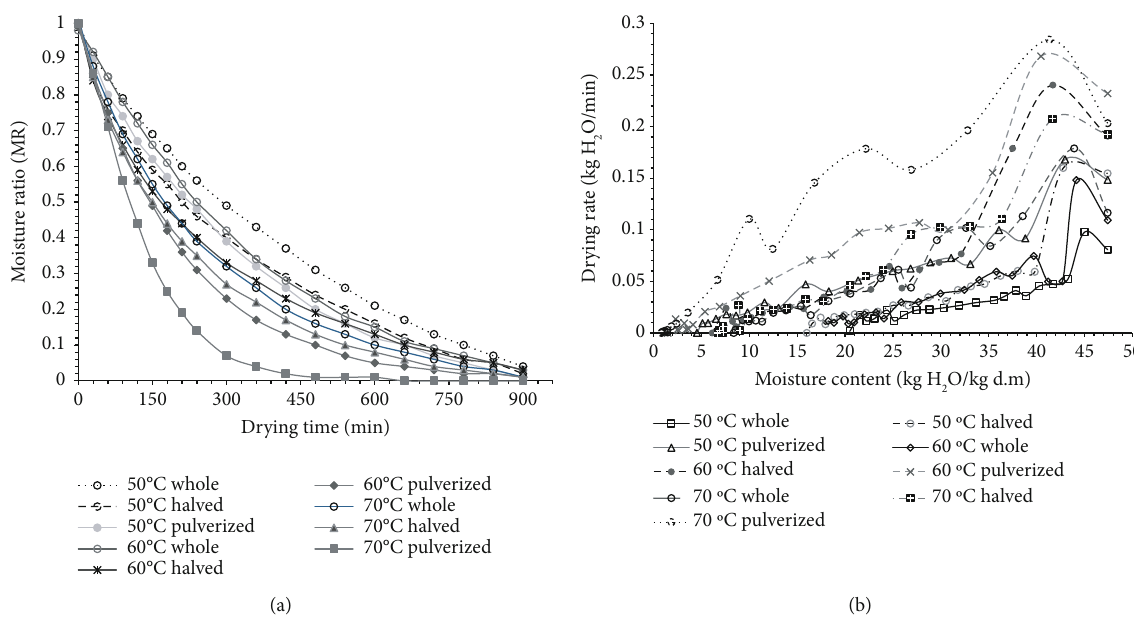
Figure 1: E ff ect of tiger nut state and air temperature on the drying characteristic curves and drying rates for the di ff erent drying conditions.